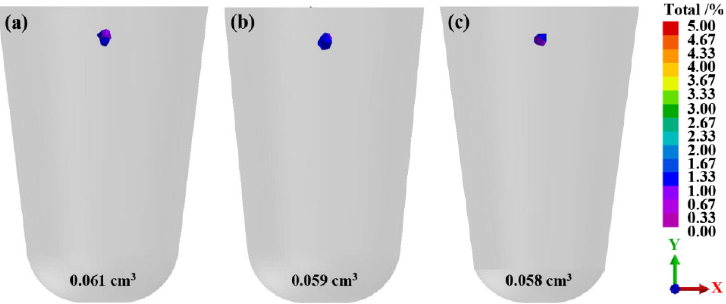
Figure 7. Distribution of shrinkage porosity for Ti ‐ 6Al ‐ 4V alloy in mold II–IV: ( a ) II; ( b ) III; ( c ) IV.